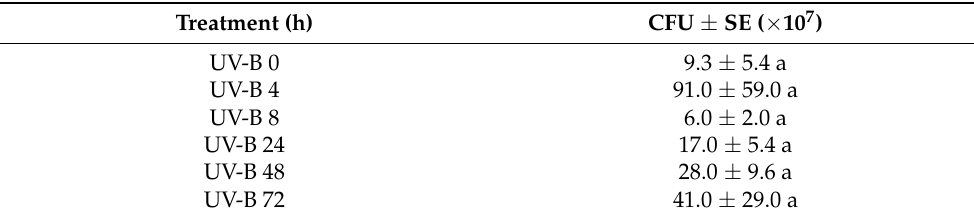
Table 4. Effect of UV-B radiation (1200 mWm − 2 ) exposure time on CFU yield by M. brunneum strain EAMa 01/58-Su